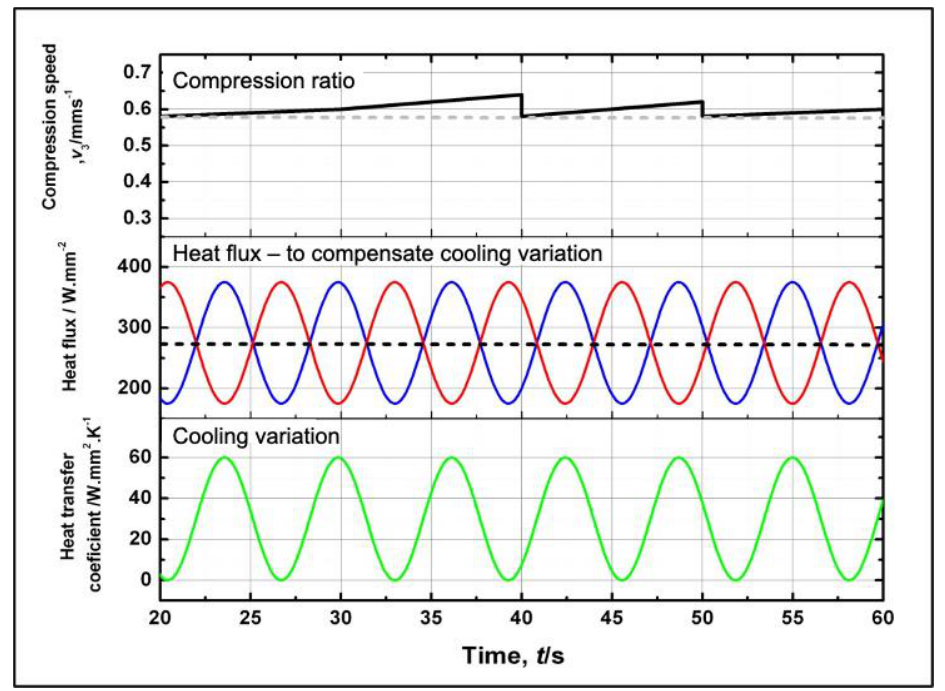
Figure 7. Compensations under various, different temperatures through applying changes in the heat flux and the compression speed.